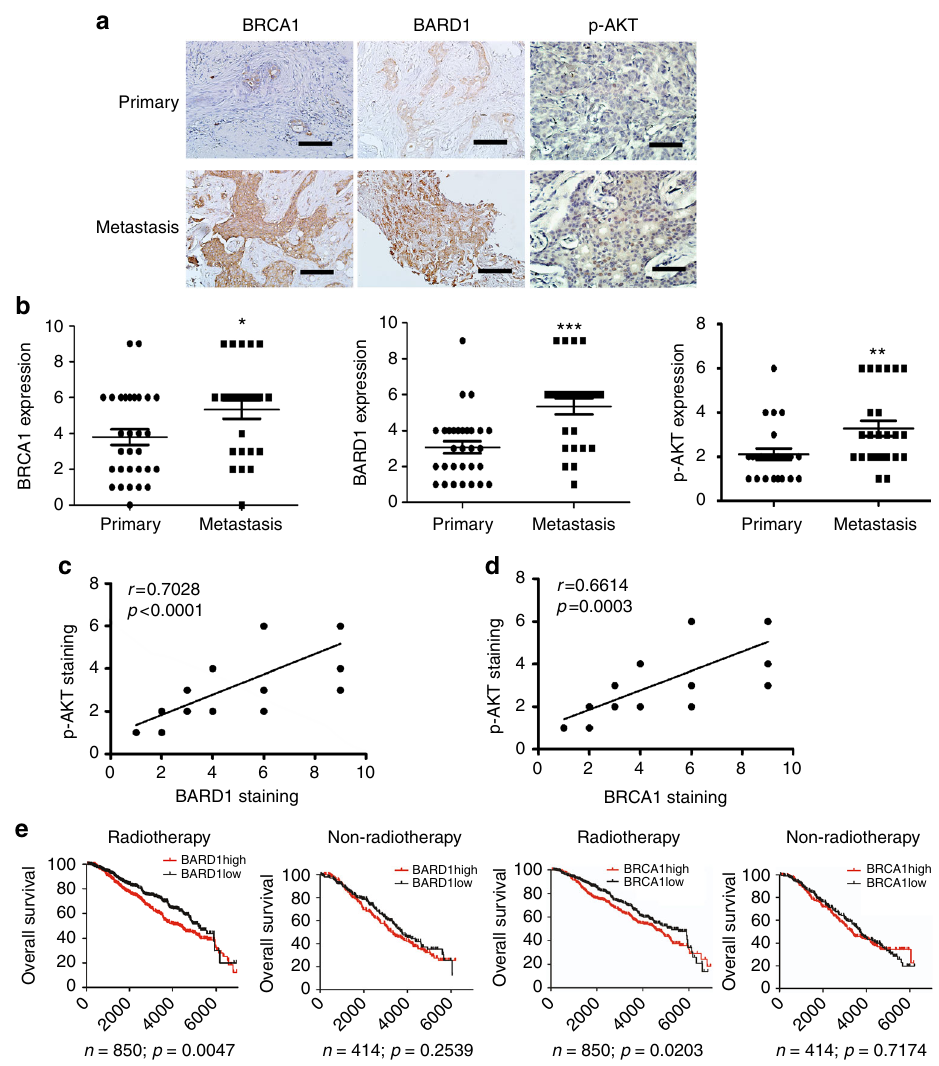
Fig. 6 The expression of BARD1 and BRCA1 are increased in metastatic breast cancer and associated with poor prognosis in ER + breast cancer patients received radiotherapy. a , b Representative pictures ( a ) and quanti fi cation ( b ) of IHC staining of BARD1, BRCA1, and p-AKT in paired primary and metastatic breast cancer tissues. c , d Correlation analysis of p-AKT expression with BARD1 ( c ) or BRCA1 ( d ) expression in primary and metastatic breast cancer samples. e Overall survival of breast cancer patients in Curtis data set with or without radiotherapy whose tumors had high or low BARD1/BRCA1 expression. In b , data show means ± s.d. ( n = 27) * p < 0.05; ** p < 0.01; *** p < 0.001 compared with that in primary breast cancer by Student ’ s t test. Scale bar indicated 400 µ